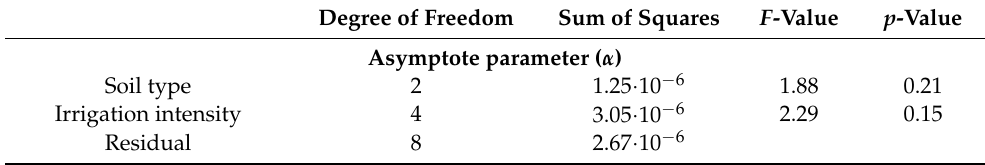
Figure 2. Relative increment of the third-year seedlings of Norway spruce according to the studied soil types and irrigation intensities (proportion of natural precipitation) at the end of experiment. Lines show medians, boxes represent the first and third quartiles, whiskers mark the range (not ex- ceeding 150% of the interquartile distance), and circles denote outliers of the datasets. The intra-annual growth patterns were mainly affected by IRIN, as suggested by the differences in the parameters of the fitted logistic growth functions (Table 3). A stronger effect of IRIN was observed for β and, particularly, k parameters. The displacement pa- rameter ( β ) was mostly proportional to the IRIN, while the growth rate parameter ( k ) showed an inverse relationship (Figure 3), implying that water deficit resulted in a faster cessation of shoot elongation (Figure 4A–C). Soil type had a marginal effect ( p = 0.048) on the growth rate parameter (Table 3), which decreased with increasing soil fertility (Figure 3), implying slower growth, which, however, ceased later on more fertile soil (Figure 4A–C). The maximum weekly RGR (asymptote, α ) appeared unaffected by the studied treatments (Table 3), though it varied among the treatment combinations. Under the control treatment, seedlings that received ground water and were subjected to a differ- ent soil temperature regime (not shown) ceased growth approximately two weeks later (Figure 4A–C) and formed larger relative increments (Figure 2). Table 3. The ANOVA (type II tests) table of the three parameters of logistic growth function (growth asymptote, displacement, and growth rate) of height growth cessation (after peak) of the studied third-year Norway spruce seedlings according to soil type and irrigation intensity. A single function was fit for each treatment. The interaction terms were not calculated due to limitations of the dataset. Degree of